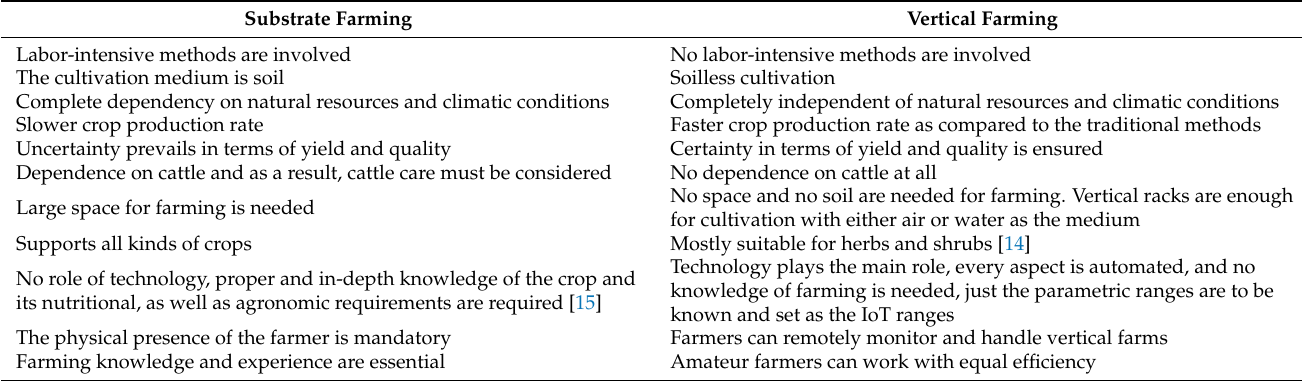
Table 1. Substrate farming vs. vertical farming. Substrate Farming